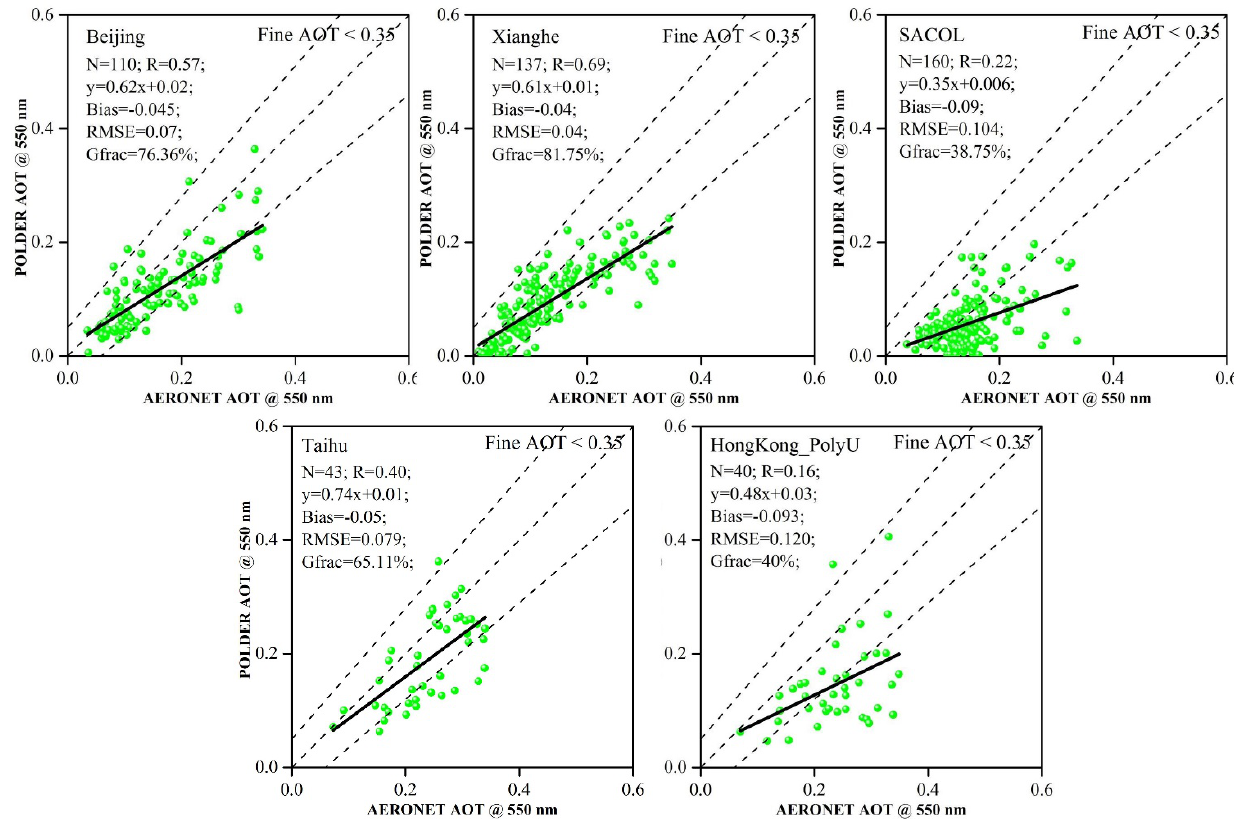
Figure 9. Scatter plots for POLDER fine-AOTs under low aerosol loading days over the five AERONET sites of